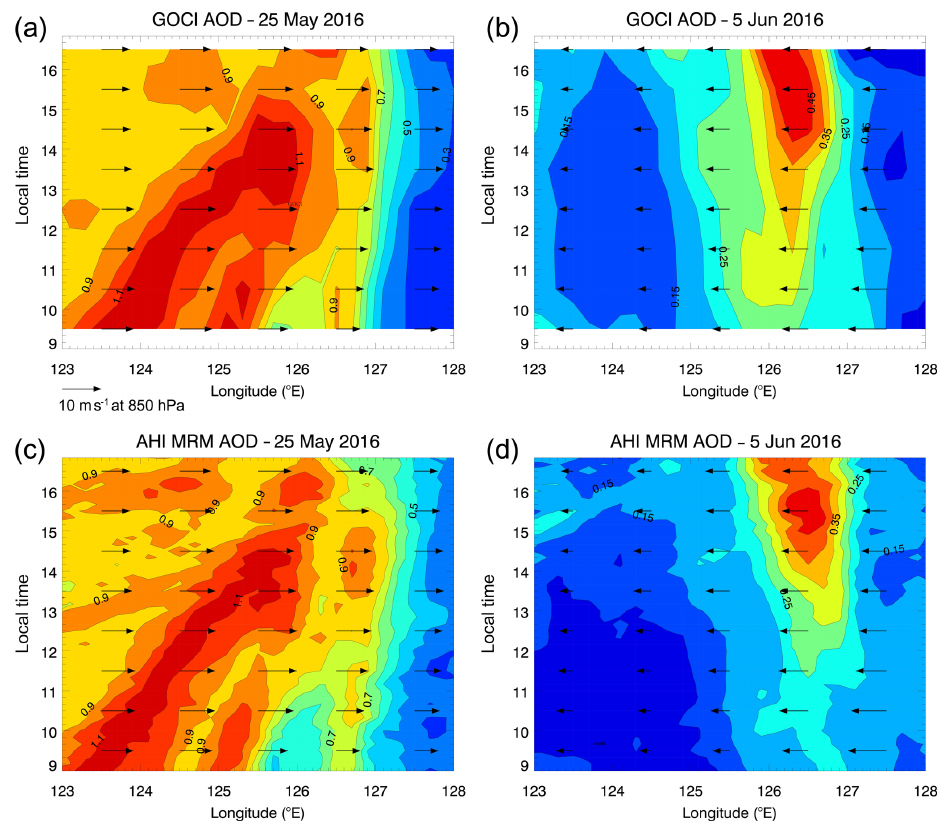
Figure 7. Meridional mean GOCI AOD over the Yellow Sea and the Korean Peninsula (35–38 ◦ N, 123–128 ◦ E) at 0.2 ◦ longitude intervals on (a) 25 May and (b) 5 June 2016. Meridional mean AHI MRM AOD on (c) 25 May and (d) 5 June 2016. Overlapped arrows represent meridionally averaged zonal wind at